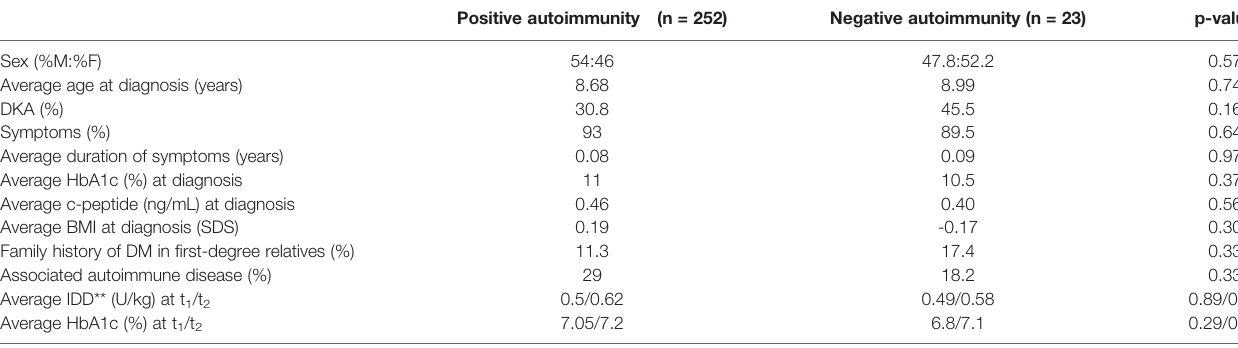
TABLE 1 | Clinical characteristics, anamnestic and biochemical data of the participants subdivided in 2 groups, expressed on average. Positive autoimmunity (n =